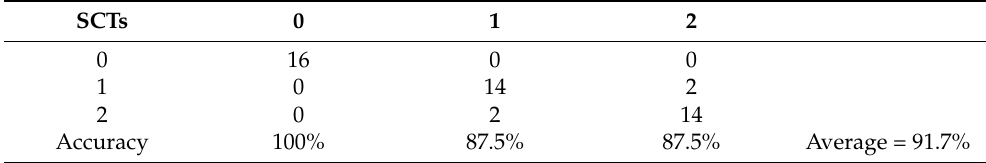
Table 4. Confusion matrix for SCTs